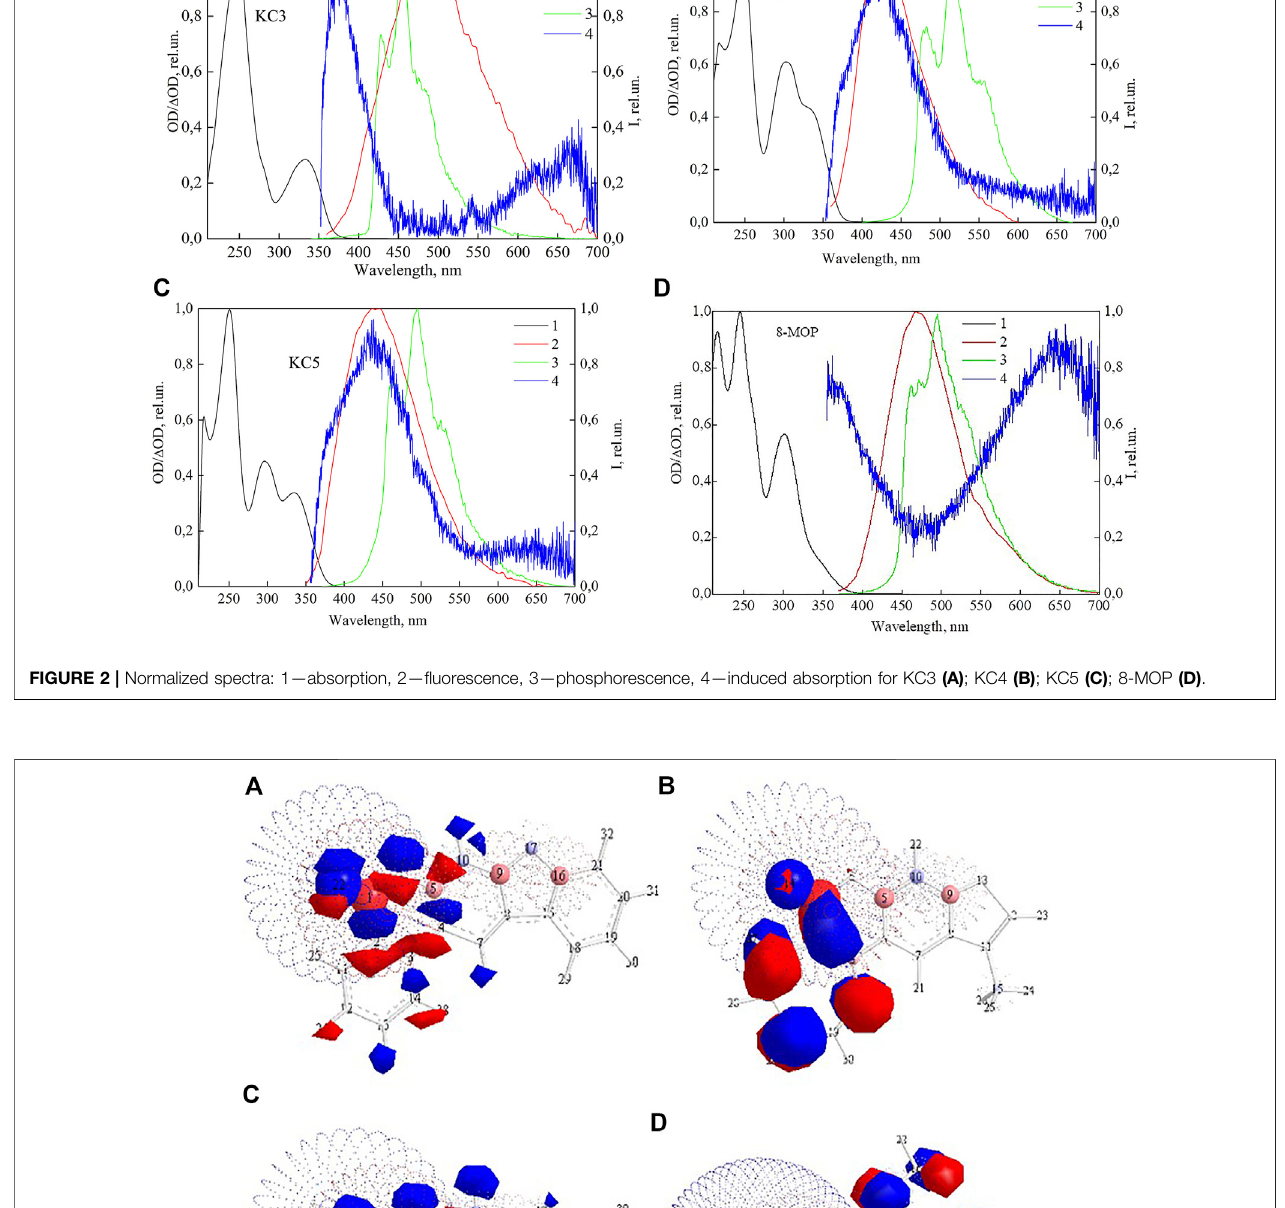
Frontiers in Chemistry |